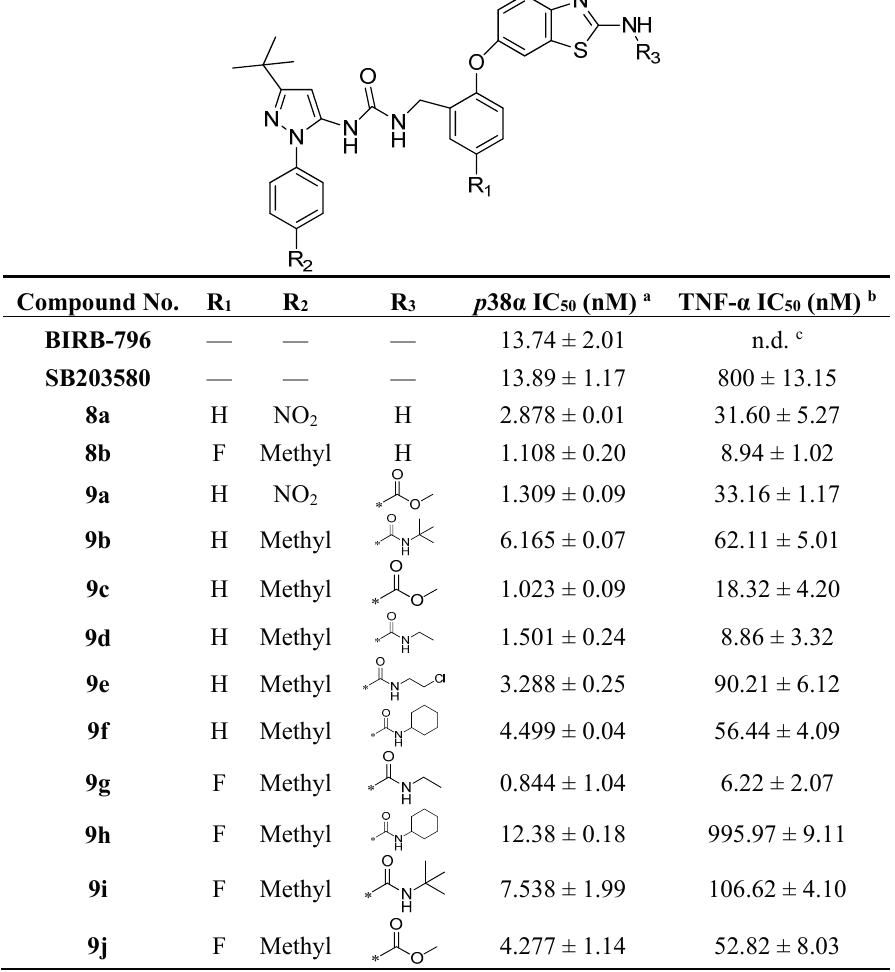
Table 1. Structure and biological activity of compounds 8a – 8b , 9a – 9j .